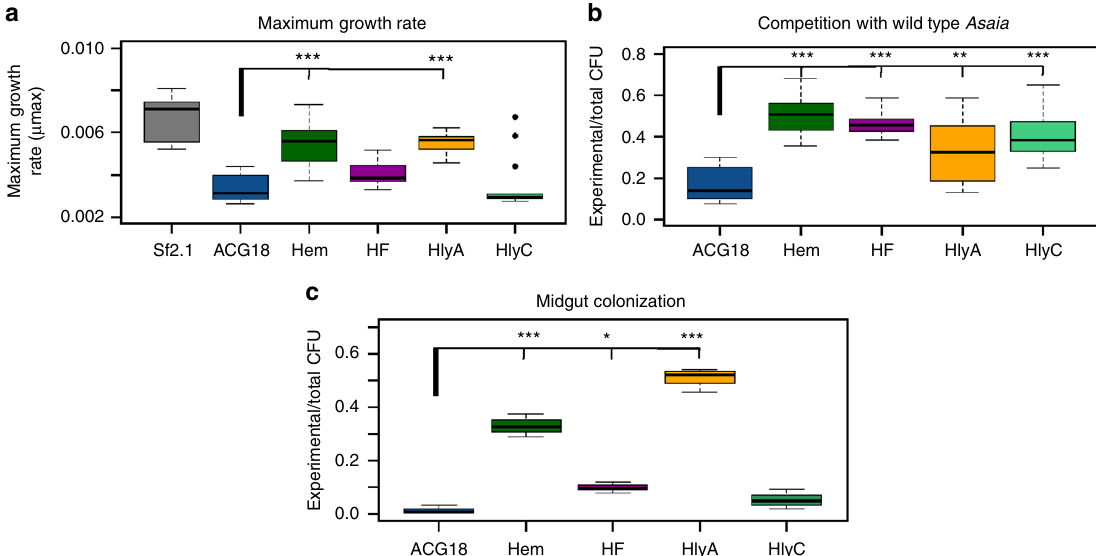
Fig. 5 BMI strains demonstrate increased fi tness compared to a constitutively-expressing strain. a Growth curves and maximum growth rates were calculated from 10 individual isolates of each strain grown over log phase of the bacteria using RStudio; b Each strain was competed in minimal media with wild-type Asaia SF2.1 in an initial 50/50 co-culture during log phase of the bacteria. Ratios of transgenic vs. whole culture CFUs are displayed. A 50:50 ratio indicates no loss of the paratransgenic strain during the course of the experiment; c Antiplasmodial Asaia strains were fed to mosquitoes and 10 midguts from each sample were pooled and plated on selective media. Transgenic CFUs were counted for each isolate and taken as a ratio of the total across all strains. For each panel, box bars are medians. The top and bottom of the boxes represent the fi rst and third quartile of the data spread. The lower and upper bounds of the whiskers are the lowest datum still within 1.5X interquartile range (IQR) of the lower quartile, and the highest datum still within 1.5X IQR of the upper quartile, respectively. Data lying beyond the upper or lower 1.5X IQR ranges are shown as single points. Statistical signi fi cance for each experiment was determined using one way ANOVA with Dunnett ’ s correction where signi fi cance is represented by * P < 0.05, ** P < 0.01, and *** P < 0.001 with experimental replicates ( n = 10, a ; n ≥ 10, b ; n = 3, c ). Only signi fi cant comparisons are